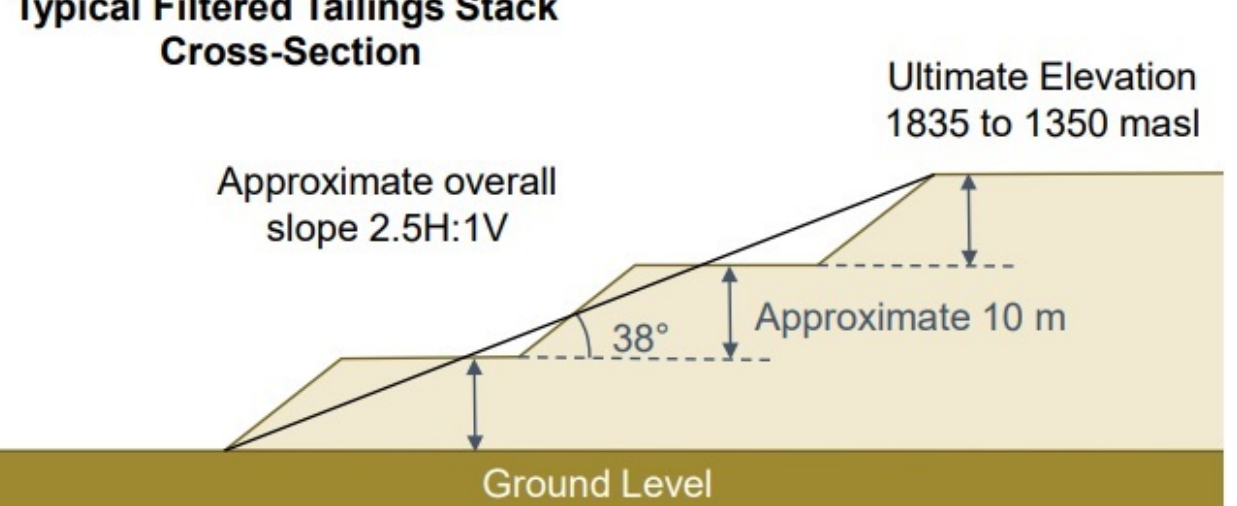
Figure 31. El Peñon Filtered Tailings Storage Facility–Old and New Phase Cross Section [62,63].